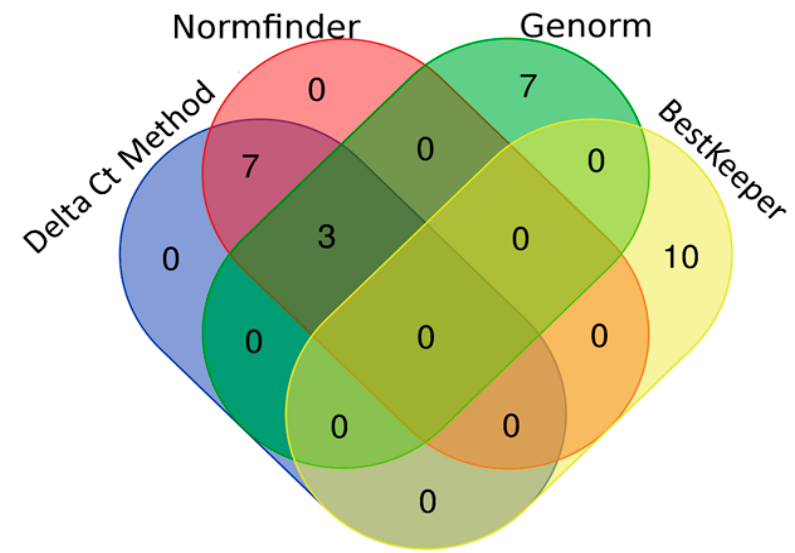
Figure 4. Venn diagram presenting the overlap among the best 10 reference miRNAs selected by each algorithm. Delta Ct method, NormFinder, Genorm and BestKeeper.